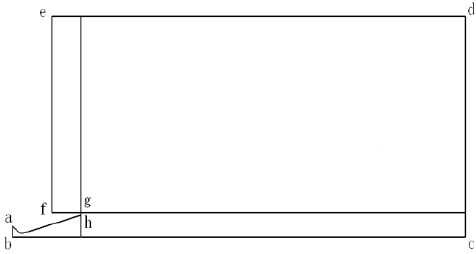
Figure 6. Schematic diagram of computing area.